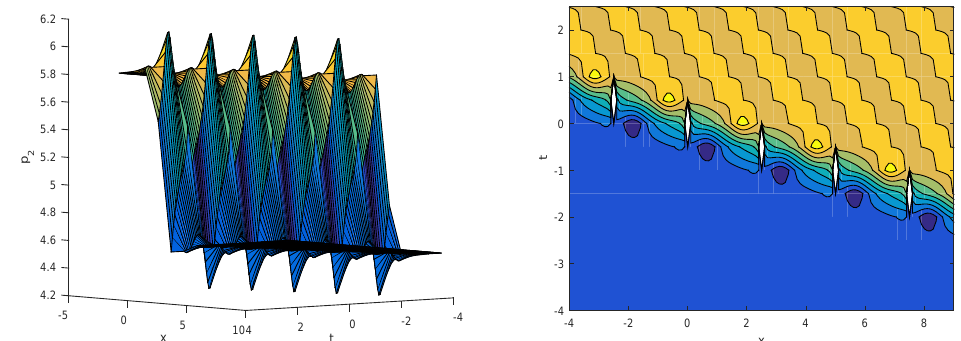
Figure 3. The above graphs show the graphical illustration of solitons in the form of the surface plots (on the left) and contour plots (on the right side) of acoustic pressure p where the values of parameters are mentioned below in C. This graph represents the behavior of solitons of Case II Equation (21) showing 3D and their contour plots of breathers distribution under solitary wave background.